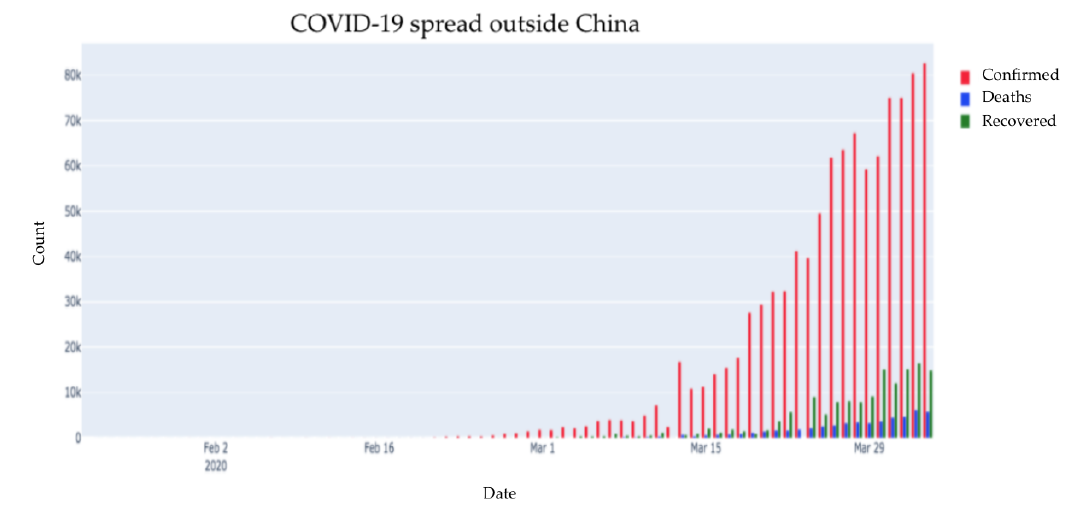
Figure 5. Distribution of all three cases outside China.